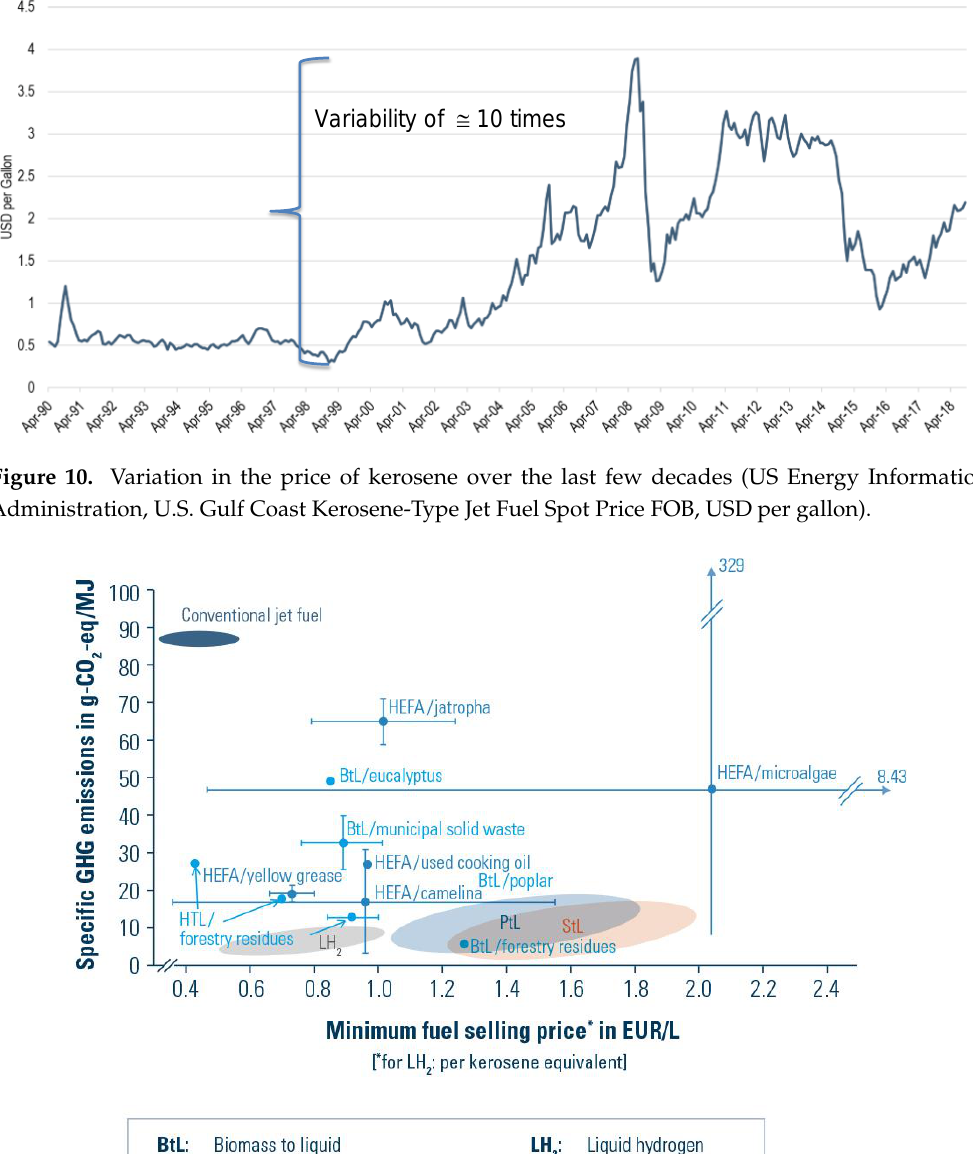
Figure 10. Variation in the price of kerosene over the last few decades (US Energy Information Administration, U.S. Gulf Coast Kerosene-Type Jet Fuel Spot Price FOB, USD per gallon).